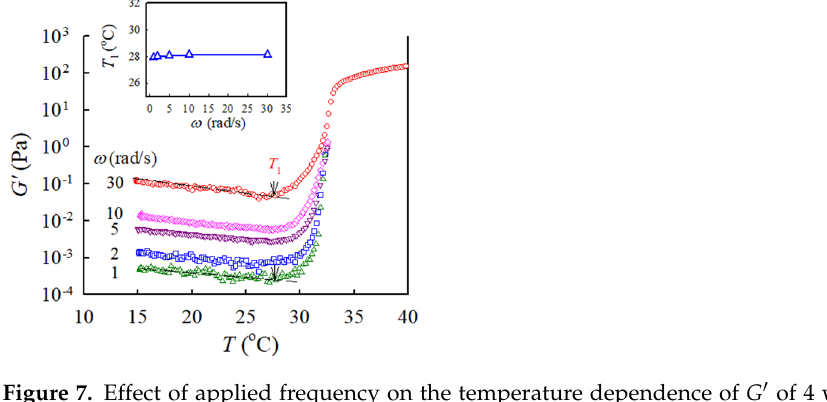
Figure 7. Effect of applied frequency on the temperature dependence of G ′ of 4 wt% a-PNIPAM solutions during temperature sweep at a heating rate of 0.2 °C/min. Arrows indicate the onset of G ′ upturn. Inset shows the frequency effect on the determined T 1 .